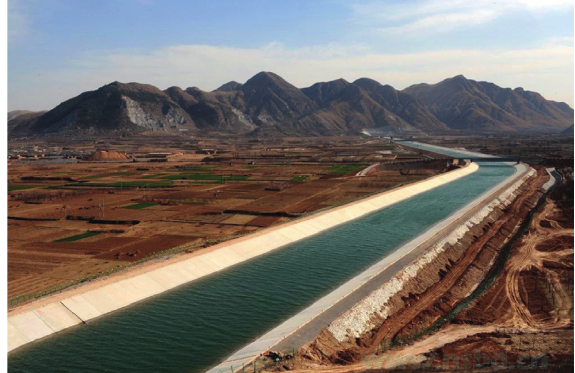
Figure 2: Water channel of the middle route of the South-to-North Water Diversion